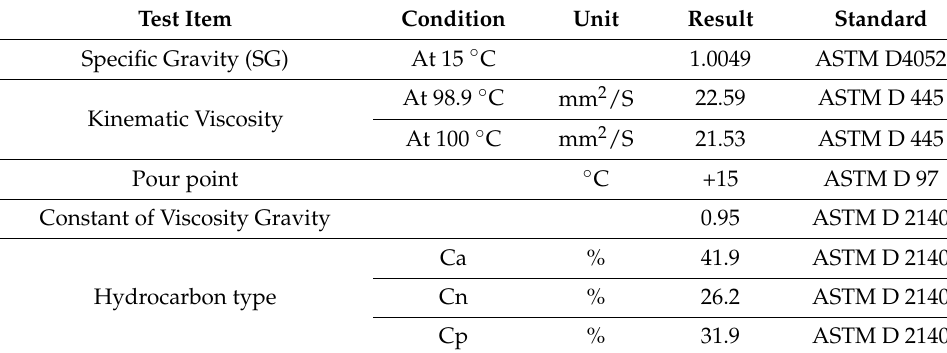
Table 3. Processed oil Properties